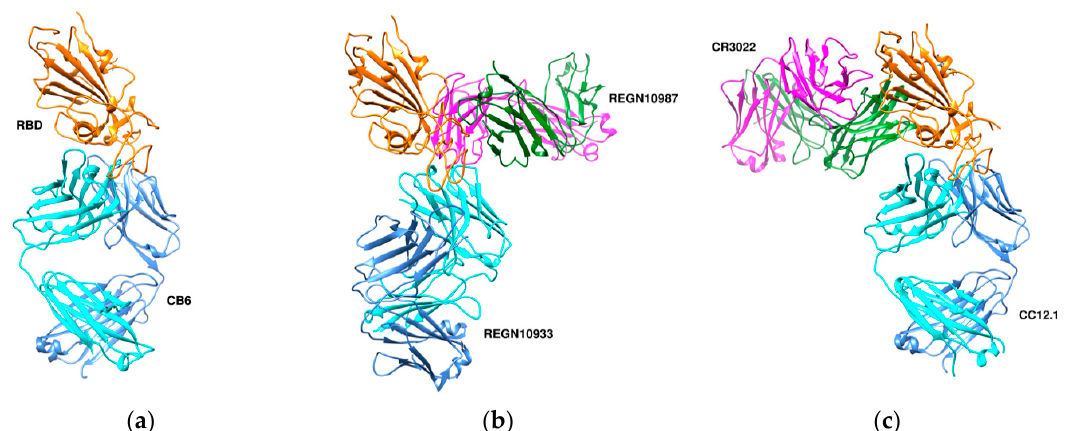
Figure 7. Three different binding modes of neutralizing antibodies. ( a ) Human neutralizing CB6 antibody in complex with SARS-CoV-2 RBD (PDB id 7c01). RBD, H, and L chains are shown in orange, cyan, and cornflower blue colors, respectively. ( b ) REGN antibodies bound to RBD (PDB id 6xdg, ( c ) CR3022 and CC12.1 in complex with ACE2 RBD (PDB id 6xc3). RBD is colored in orange, heavy chains in cyan and green, and L chains in cornflower blue and magenta. The RBD (in orange) is shown in the same orientation in all three complexes.